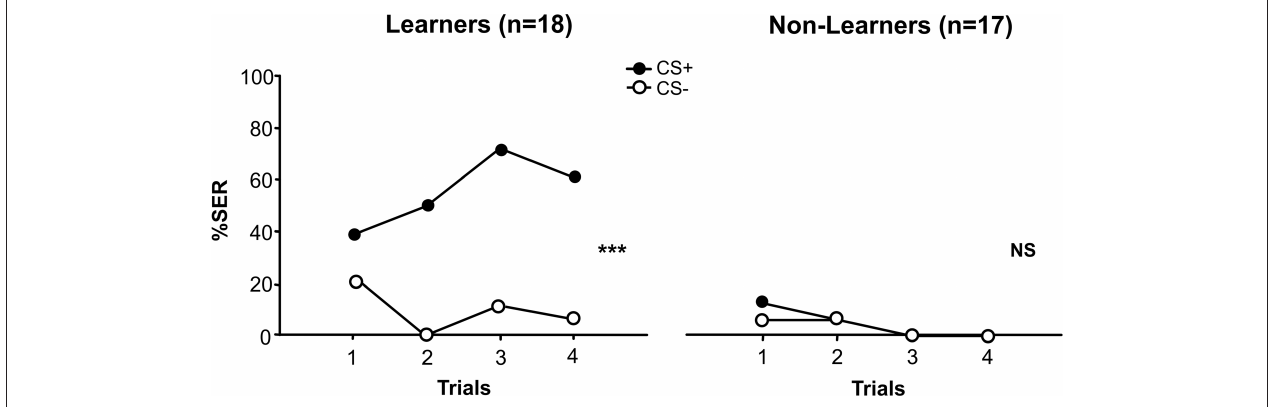
Figure 2 | Learning curves of conditioned bees. We distinguished learners from non-learners. Learners mastered the olfactory discrimination as they responded more to the CS + than to the CS − during conditioning trials ( stimulus effect: *** p < 0.001); non-learners, on the contrary, were unable to master the discrimination ( stimulus effect: p =